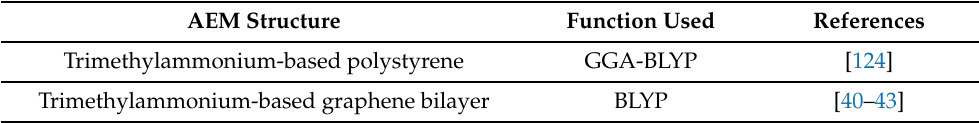
Table 2. Recent ab initio MD studies on AEMs AEM Structure Function